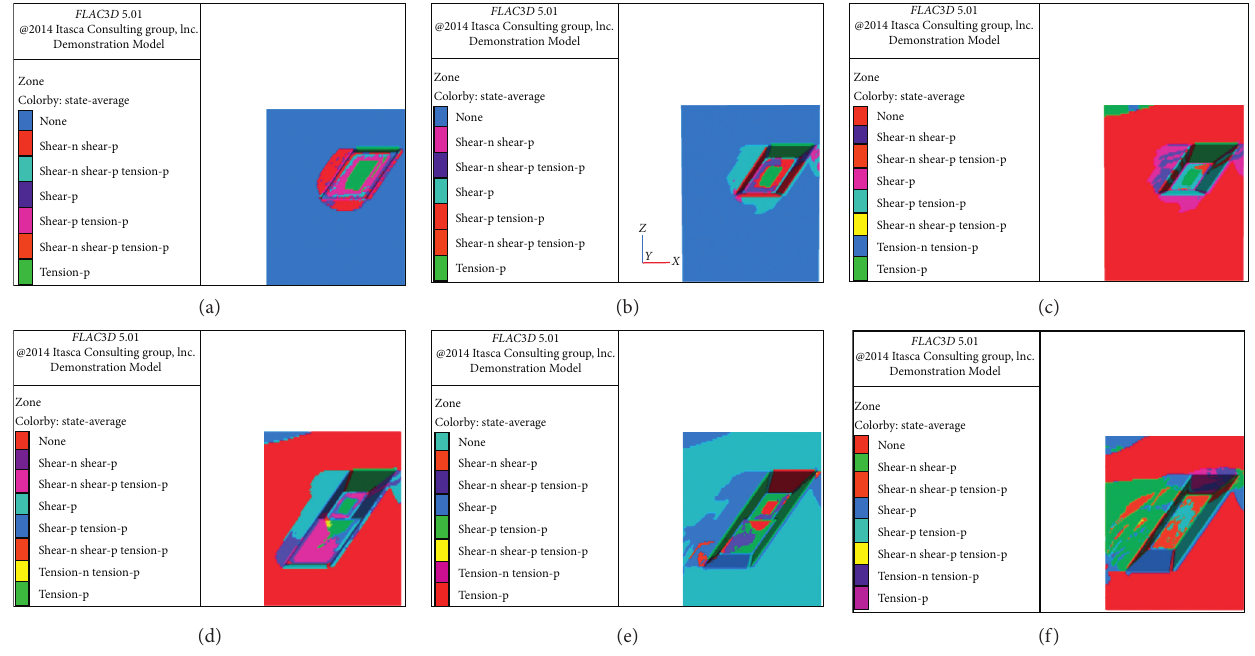
Figure 13: Rock’s plastic zone distribution. (a) The upper section advances 10 m. (b) The upper section advances 50m. (c) The upper section advances 100m. (d) The lower section advances 10 m. (e) The lower section advances 50m. (f) The lower section advances